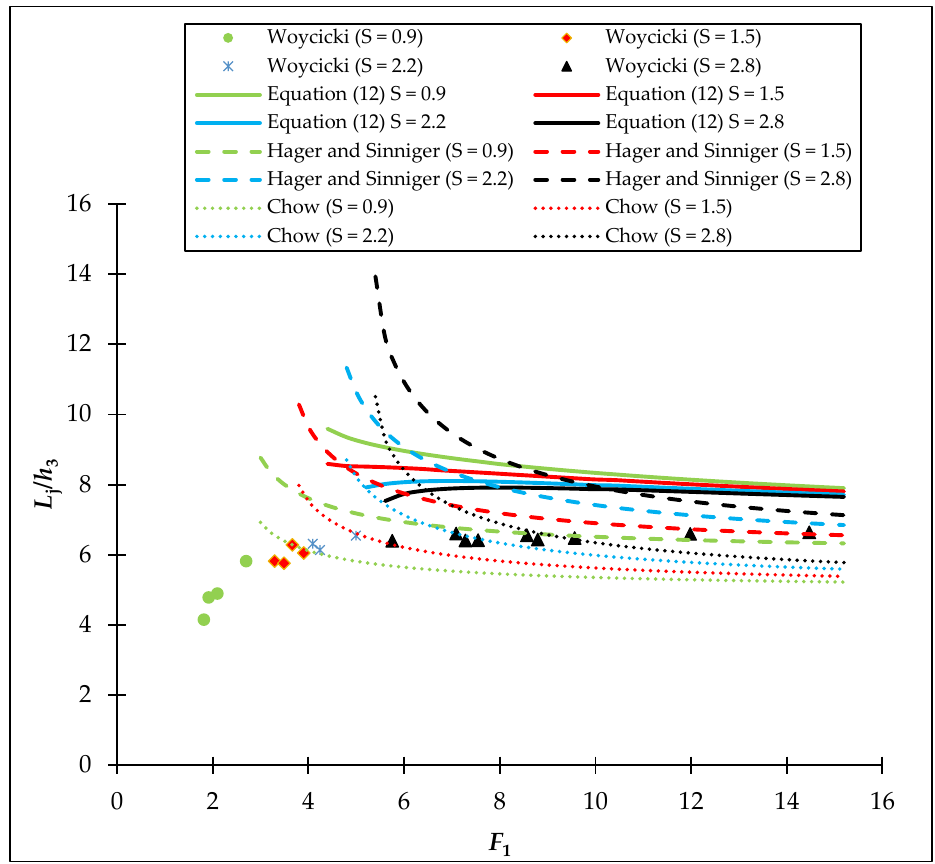
Figure 3. Relative jump length variation with initial Froude number.